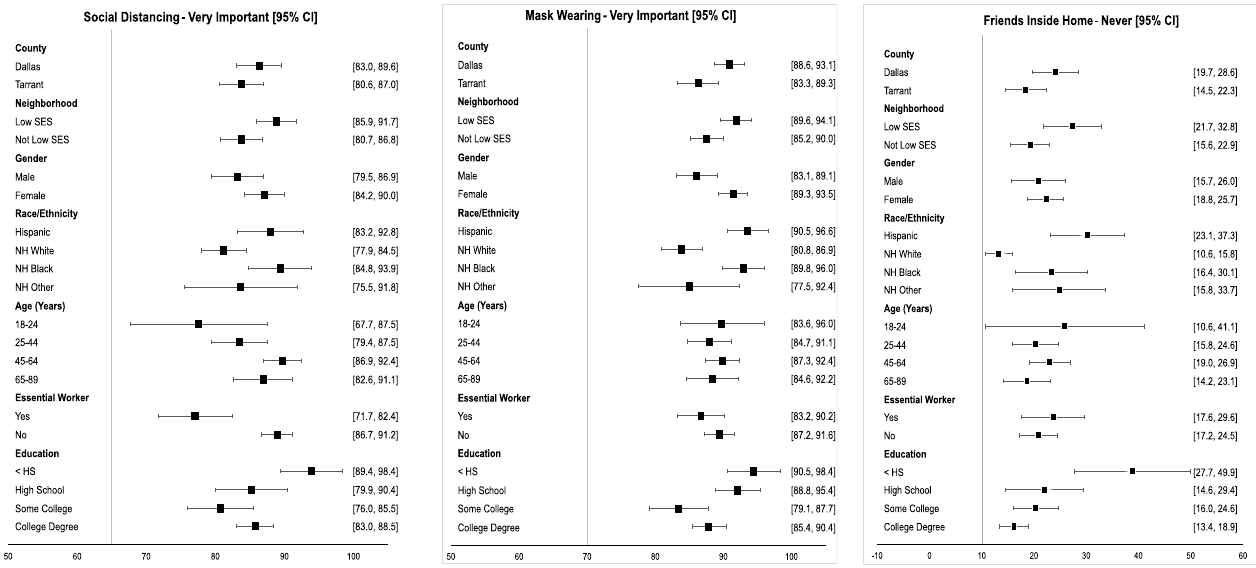
Fig 1. Estimated prevalence by select beliefs that lower risk of COVID-19 infection. SES = Socioeconomic status. Non-Hispanic (NH) Other is comprised of racial groups other than White and Black including multiracial. Essential workers (Yes) are defined as those who worked onsite in the past 30 days at the time of the survey most of the time and who came into frequent contact with the public. The ‘No” category includes those not working (e.g., student, retired). Education: < HS = less than high school/ high school no diploma; HS = high school, vocational, business or trade school; some college = some college no degree/associate degree; college degree = 4-year college/university degree/graduate